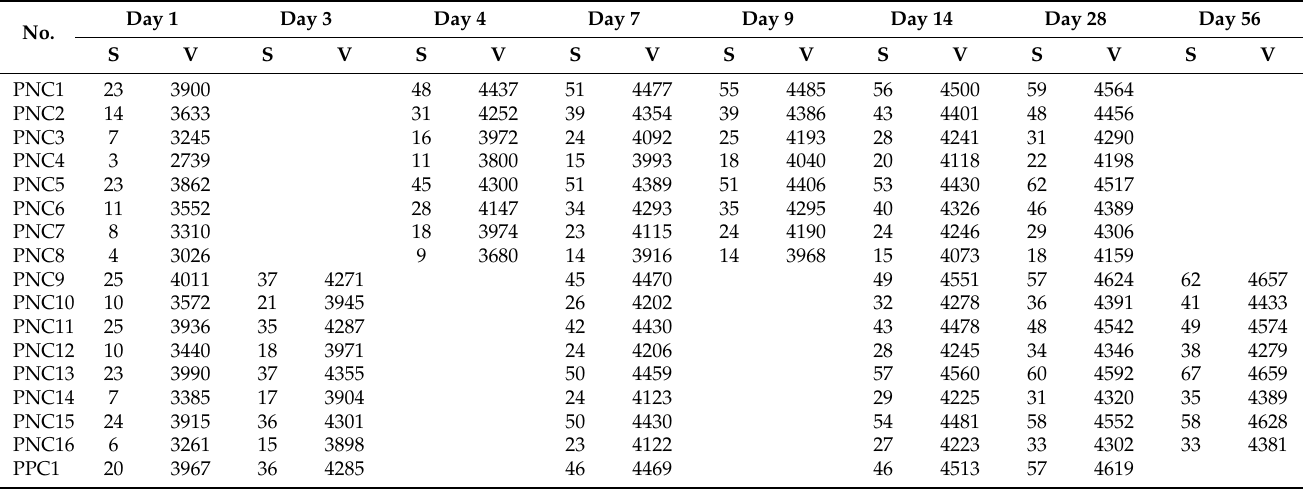
Table 9. The measured UPV and strength data collected for normal concrete.